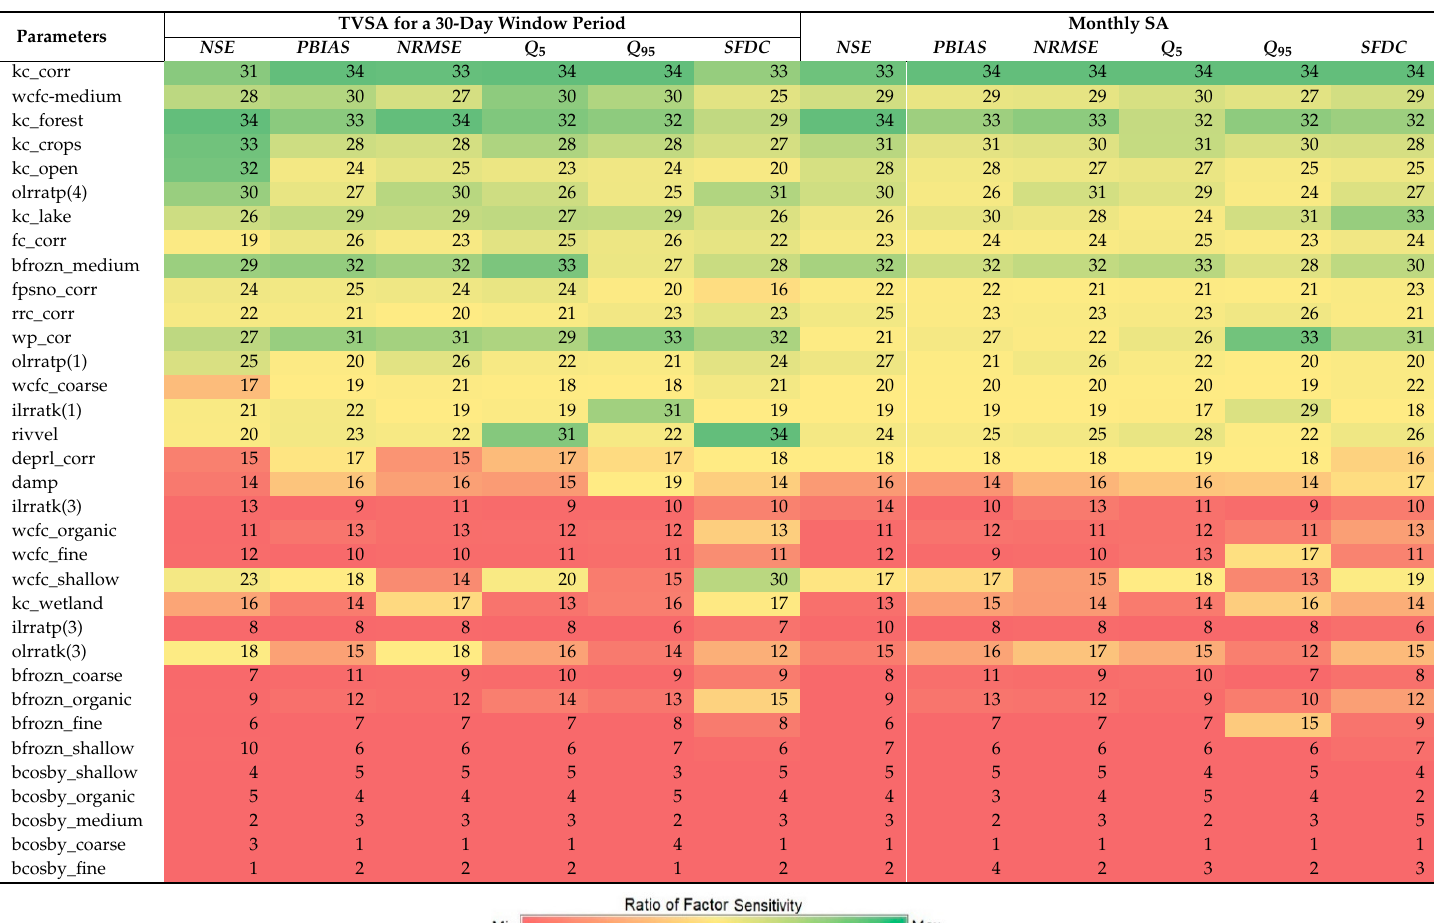
Table 4. Comparison of the ranking of model parameters based on maximum ratio of factor sensitivity (RFS), from most influential (green) to least influential parameter (red) determined from time variant sensitivity analysis (TVSA) on 30-day window period (IVARS 50 ), and monthly SA using di ff erent evaluation metrics.